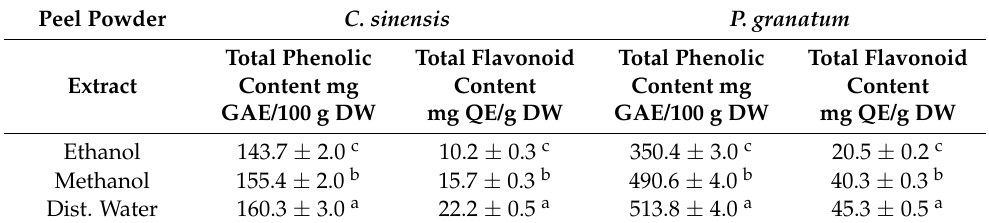
Table 5. Total phenolic and total flavonoid of C. sinensis and P. granatum peel extract. Peel Powder C. sinensis